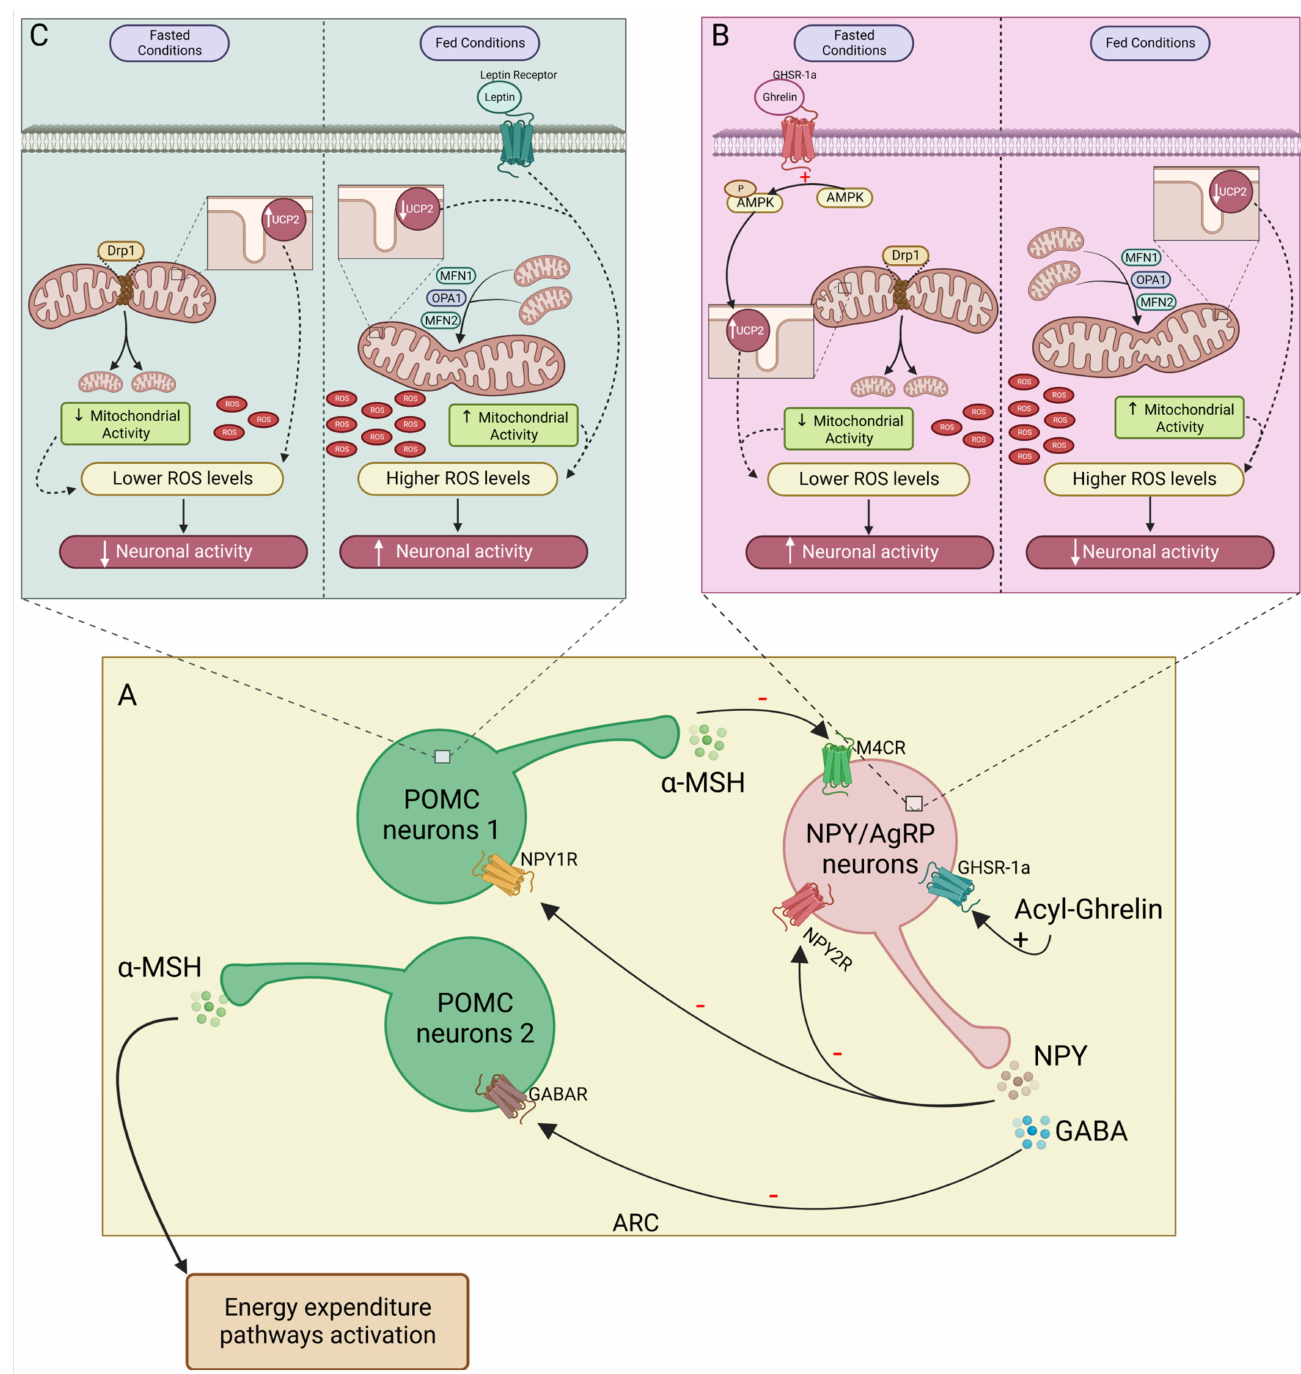
Figure 1. Mitochondrial function on NPY/AgRP and POMC neurons activity. ( A )—In the ARC during fasting acyl-ghrelin stimulates orexigenic neurons firing, releasing NPY and GABA, inhibiting POMC neurons (subpopulations 1 and 2, respectively). On post-prandial state, α -MSH released by subpopulation 1 of POMC neurons and NPY2R activation inhibits NPY/AgRP neurons; ( B )—During fasting, ghrelin promotes AMPK phosphorylation in NPY/AgRP neurons. Mitochondrial fission is stimulated by Drp1 and AMPK-induced UCP2 expression contributes to lowering ROS levels. Upon feeding, MFN1, MFN2, and OPA1 promote mitochondrial fusion. The increase in the mitochondrial activity together with a decrease in UCP2 leads to higher ROS levels which inhibit NPY/AgRP neurons activity; ( C )—On POMC neurons, leptin and mitochondrial activity increased during feeding and contribute to the rise of ROS levels, stimulating POMC neurons activity. In fasting